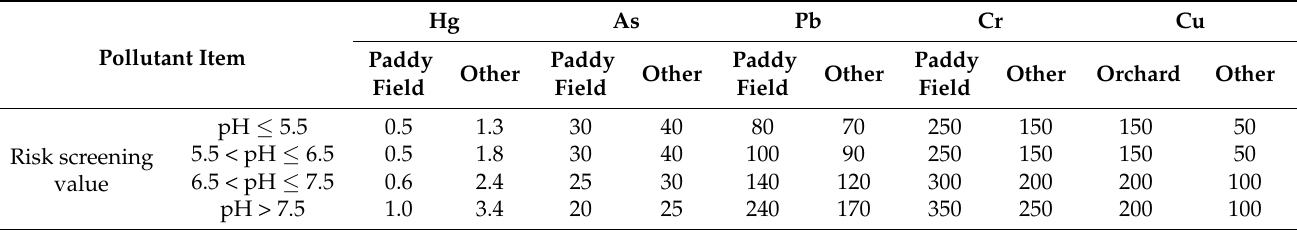
Table 1. Soil pollution risk screening value of agricultural land